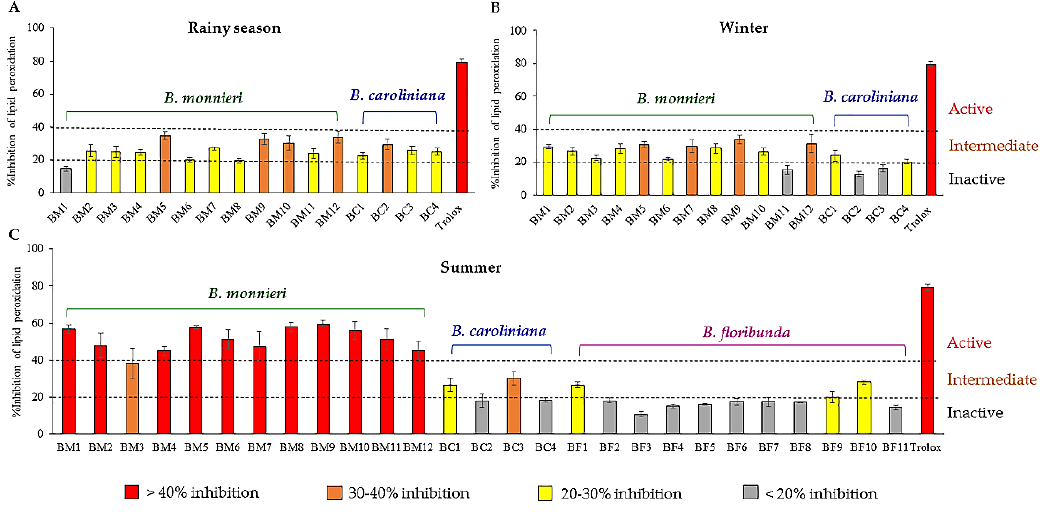
Figure 2. Anti-lipid peroxidation activities of three Bacopa species i.e., B. monnieri (BM), B. caroliniana Figure 2. Anti - lipid peroxidation activities of three Bacopa species i . e . , B . monnieri ( BM ) , B . caroliniana (BC), and B. floribunda plant (BF) collected from di ff erent regions in the ( A ) rainy, ( B ) winter and ( BC ) , and B . floribunda plant ( BF ) collected from different regions in the ( A ) rainy, ( B ) winter and ( C ) ( C ) summer seasons. Samples giving > 40% inhibition were considered active, 30-40% inhibition was summer seasons. Samples giving >40 % inhibition were considered active, 30‒40% inhibition was intermediate activity, 20-30% inhibition was low activity, and those exhibiting < 20% inhibition were intermediate activity, 20‒30% inhibition was low activity, and those exhibiting <20 % inhibition were considered inactive. Trolox (100 µ g / mL) was used as a positive considered inactive . Trolox (100 µg/mL) was used as a positive control.